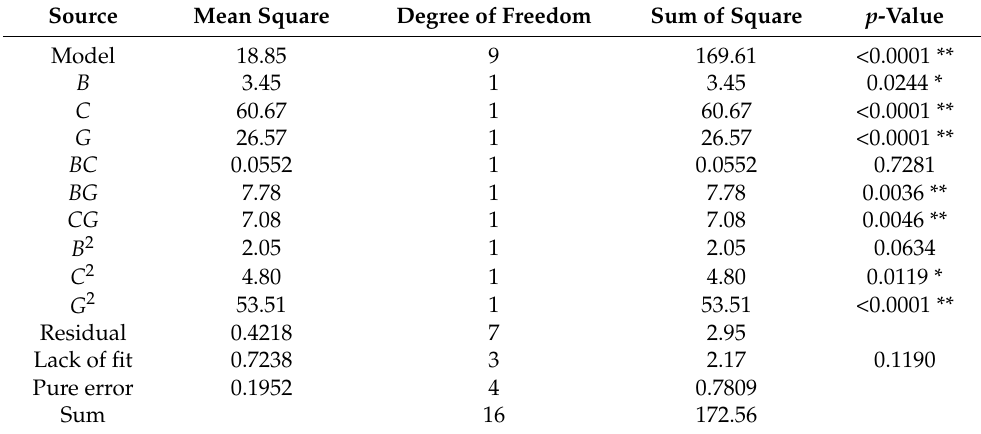
Table 10. Box–Behnken test regression model analysis of variance.